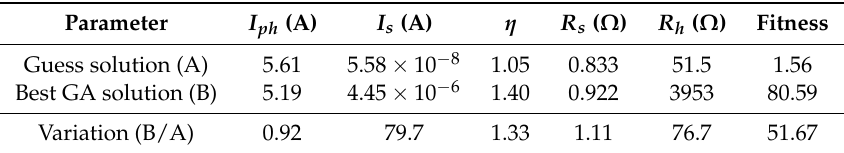
Table 6. SDM parameters’ comparison for Test